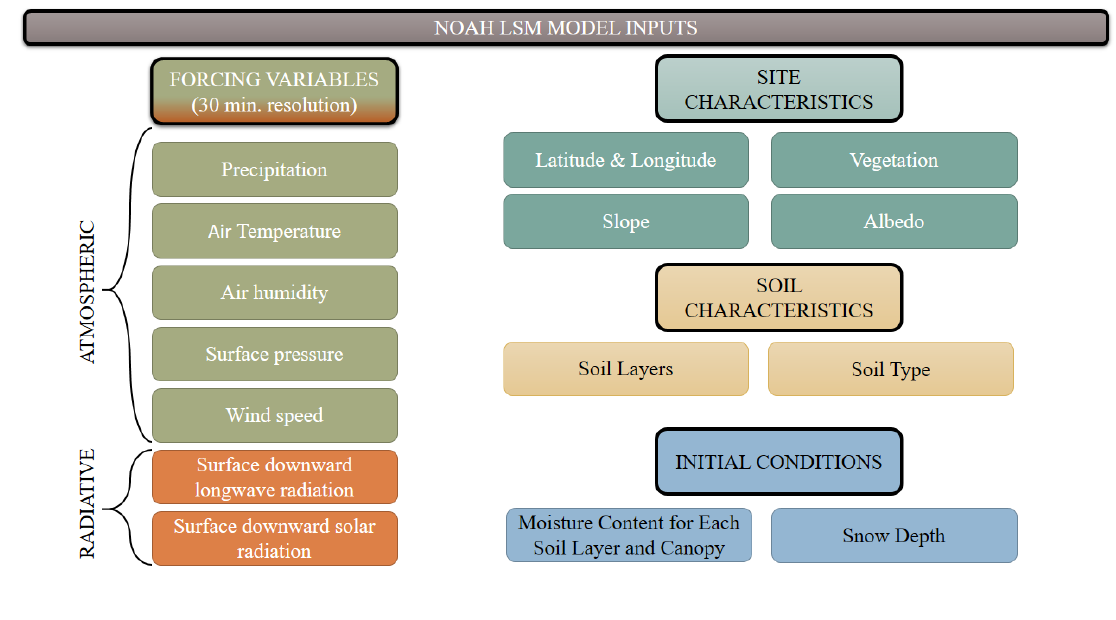
Figure 1. Input Parameters of NOAH Land Surface Model those are used in the